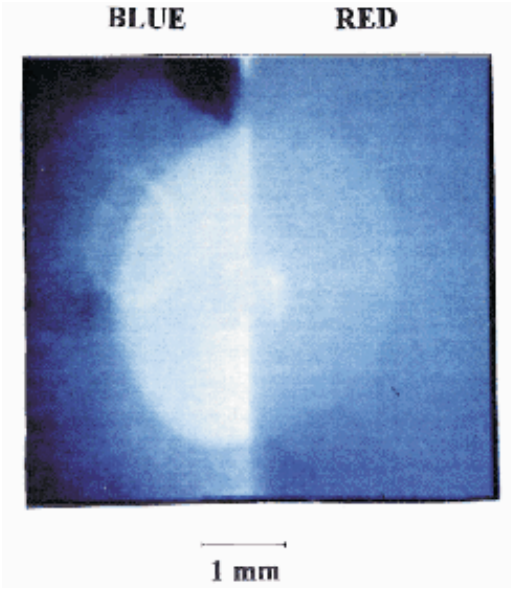
Fig. 1B – Photograph of one propagating retinal spreading de- pression wave at two wavelengths as recorded in the setup shown in Fig.1A. The photograph shows the simultaneous images from the two cameras. Note the bright spot at the center of the red scattered light image. This region is where the mechanical stim- ulation was made and it is the origin of the propagated